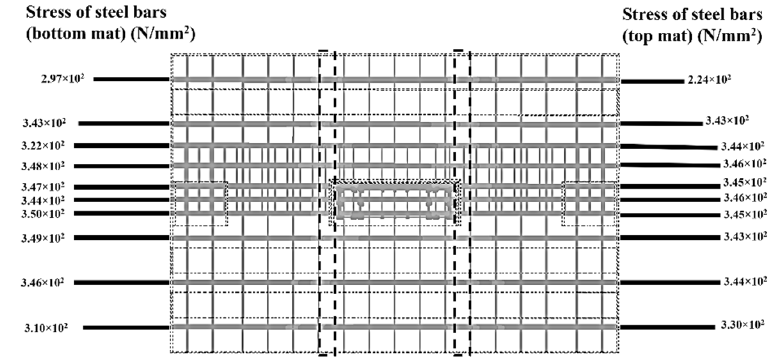
Figure 19. Comparison of lateral force ~ lateral drift ratio (%) for Model 2.